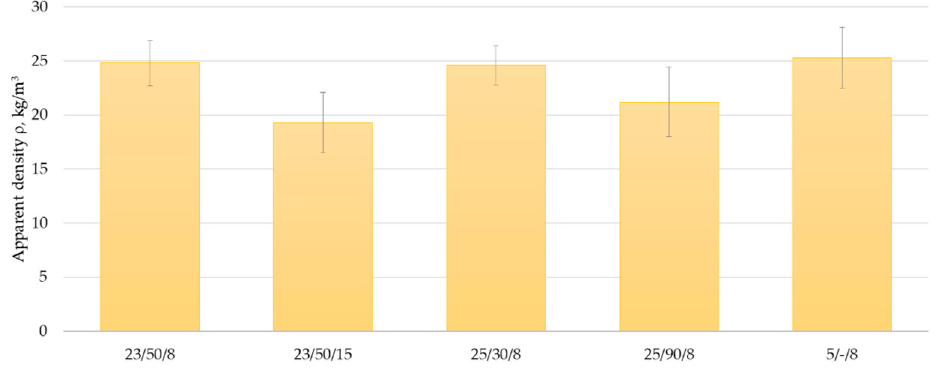
Figure 6. Apparent density of PU adhesive in bonds made under different thermal and moisture conditions. Error bars show standard deviation values.